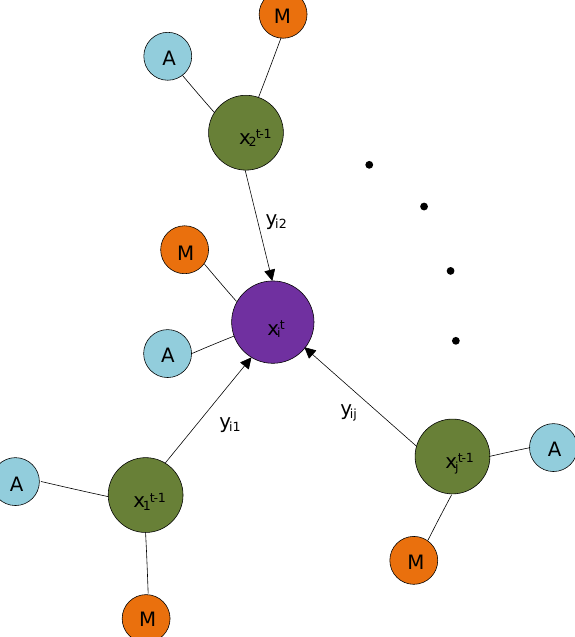
Figure 3. Graph construction. A certain detected object in current frame t is represented as x t jects in previous frame t − 1 are then defined as x t − 1 the Node x t . A and M are the appearance feature and the motion feature for respective nodes. y ij i is the edge feature connecting i -th object node in current frame t and j -th object node in previous frame t −